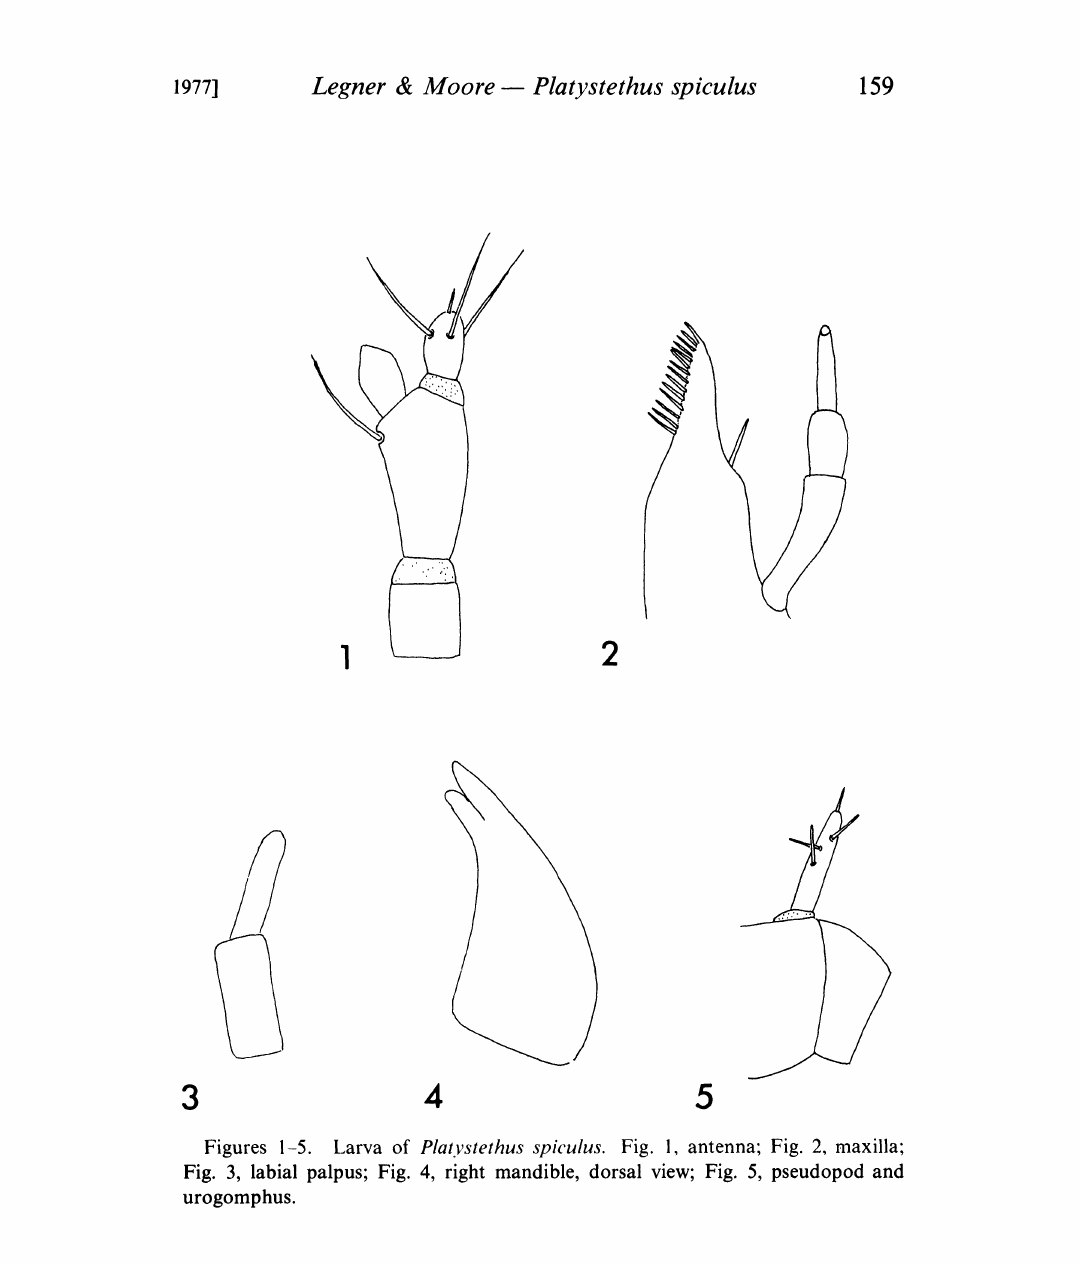
Fig. 3, labial palpus; Fig. 4, right mandible, dorsal view; Fig. 5, pseudopod and